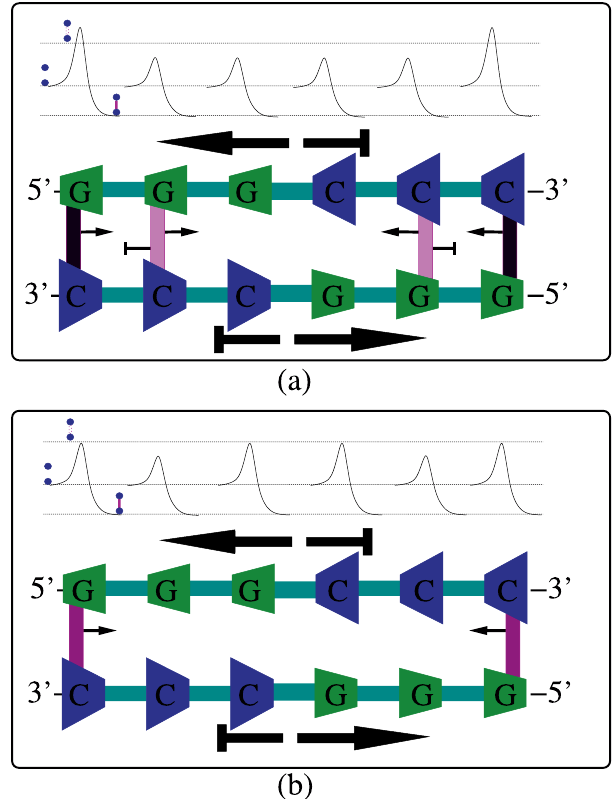
Figure 6. Parallel unzipping of the anti-parallel double strand DNA of appropriate sequence. As before, the color of the hydrogen bonds represent the height of the kinetic barrier separating bonded and unbonded configurations, higher the barrier, darker the color. Two hydrogen bonds in the middle of the double strand, between 5 ′ – GC –3 ′ /3 ′ – CG –5 ′ , reduce each others’ kinetic barriers due to dyadic symmetry of the sequence and are thus weaker than the rest of the bonds. Thus these two bonds will be the first bonds to break during temperature fluctuations, leaving their neighboring bonds on either sides with lower barriers due to the absence of their stabilizing influence. The weakening and dissociation of the hydrogen bonds thus propagate on either side of the “origin” of unzipping, simultaneously exposing two contiguous segments of the double strand to function as templates for the replica strand construction. Thus, with appropriate choice of the sequence, the anti-parallel DNA can parallelize its replication by simultaneously unzipping multiple segments and allowing for the construction of replica strand to proceed at multiple locations at once. The hypothetical parallel-strand DNA, on the other hand, would allow only for sequential unzipping from one of its ends where the kinetic barrier is lower. The additional degree of freedom offered by sequence variations cannot be utilized to parallelize replication in parallel-strand DNA, rendering the latter less